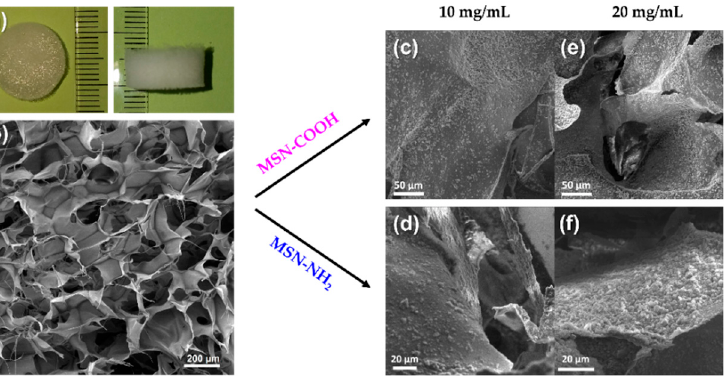
Figure 8. Photos of collagen porous scaffolds ( a ) and SEM images of collagen porous scaffolds ( b ); collagen–MSN composites prepared using 10 mg/mL ( c , d ) and 20 mg/mL ( e , f ) concentration of MSN.